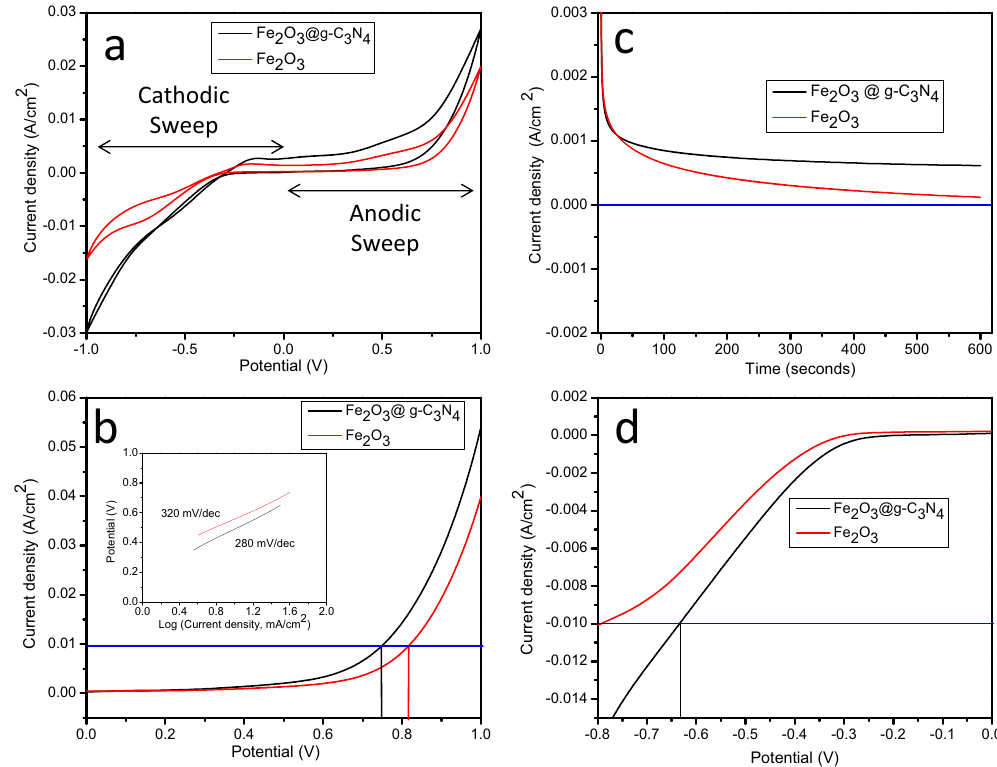
Figure 7. ( a ) CV for electrolysis of water (OER/ORR) using α -Fe 2 O 3 -NPs and mesoporous α -Fe 2 O 3 @g-C 3 N 4 - NCs electrocatalysts in 0.5 M KOH vs Ag/AgCl. ( b ) LSV curves for OER in 0.5 M KOH vs Ag/AgCl and ( c ) Stability test for OER in 0.5 M KOH at 0.5 V for 600 seconds. ( d ) LSV curves ORR in 0.5 M KOH vs Ag/AgCl. Inset of Fig. 5b shows Tafel plots of α -Fe 2 O 3 -NPs and mesoporous α -Fe 2 O 3 @g-C 3 N 4 -NCs.